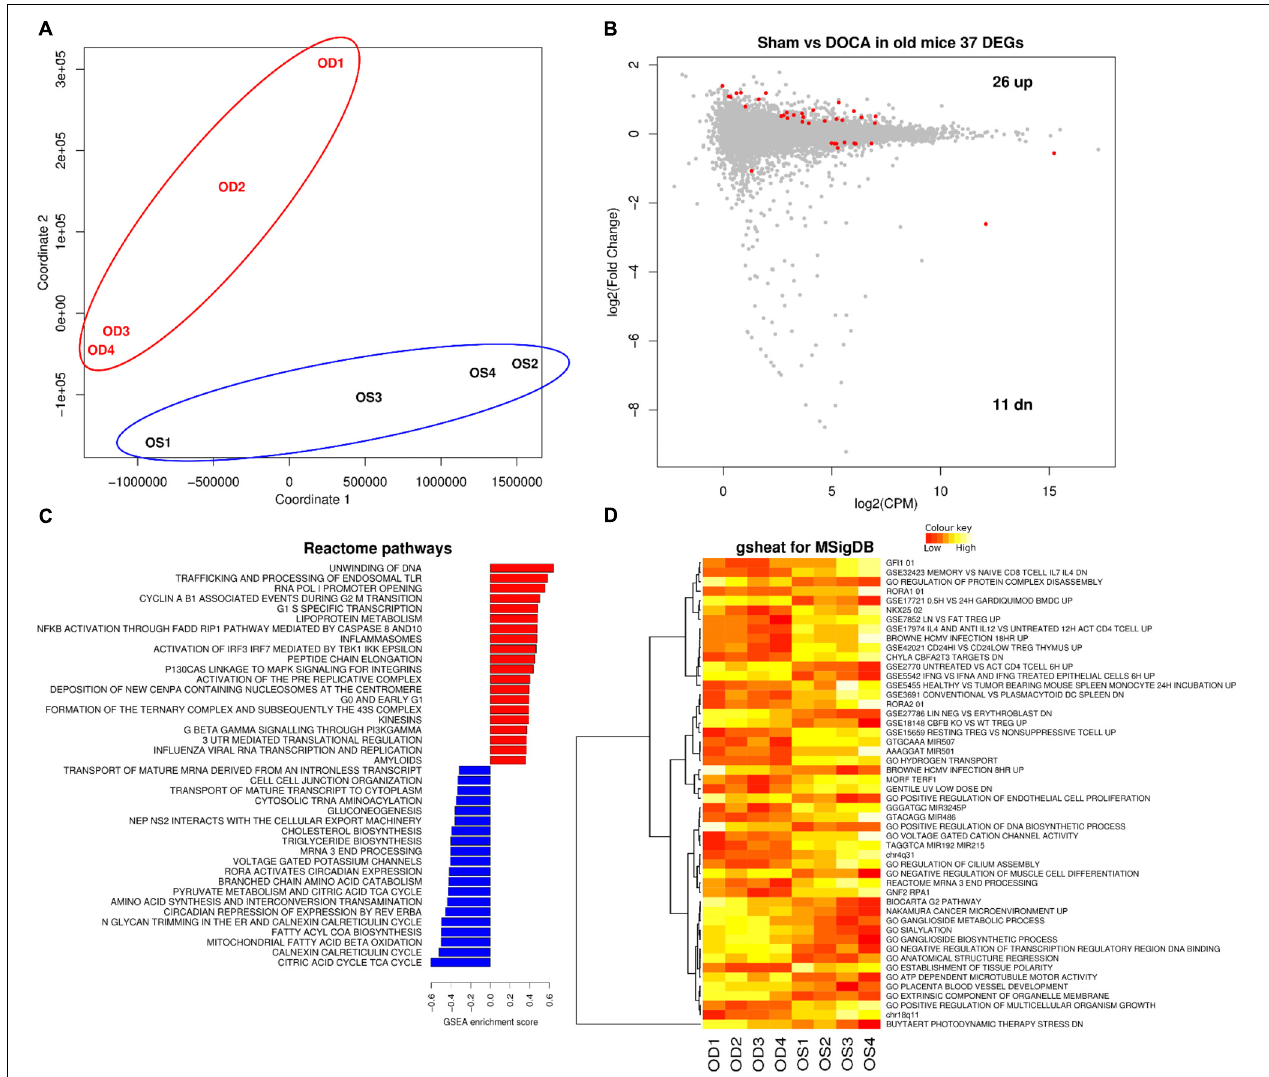
FIGURE 4 | Cardiac transcriptome in aging sham vs. DOCA mice. (A) Principal component analysis confirmed that aging sham and age-matched DOCA mice formed two distinctive groups. (B) MA plot showing 37 genes were differentially expressed between the two groups (FDR < 0.05; Supplementary Table S5). Mechanisms differentially regulated between aging sham and DOCA mice in the (C) GSEA analysis of Reactome Database and (D) Gsheat analysis of Molecular Signatures Database (MSigDB) (Supplementary Table S6). Sample size: n = 4 per group. CPM, counts per million; OD, aging DOCA; OS, aging